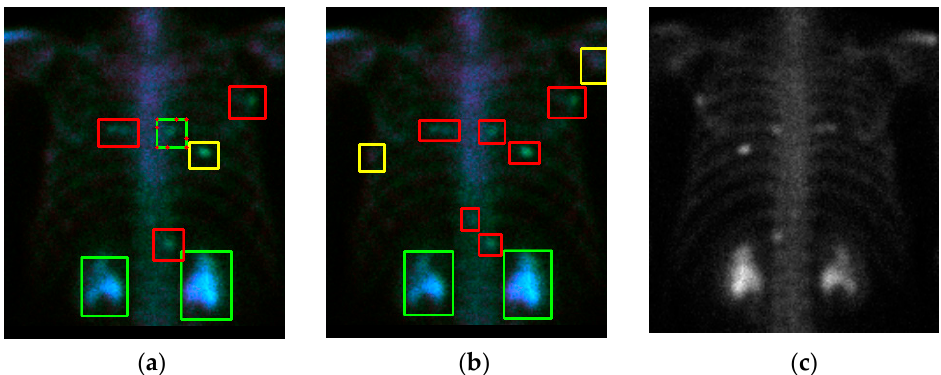
Figure 5. The qualitative result (case number 63) of our model. ( a ) Detection and classification results; ( b ) ground truth; ( c ) the raw PA view (without flipping). The red box denotes metastasis, the yellow box denotes equivocal, the green box denotes the normal or injury. The green box with red dots denotes this ROI has two class probabilities: however, solid box has a larger probability than doted box has. The same meanings are in the following figures.